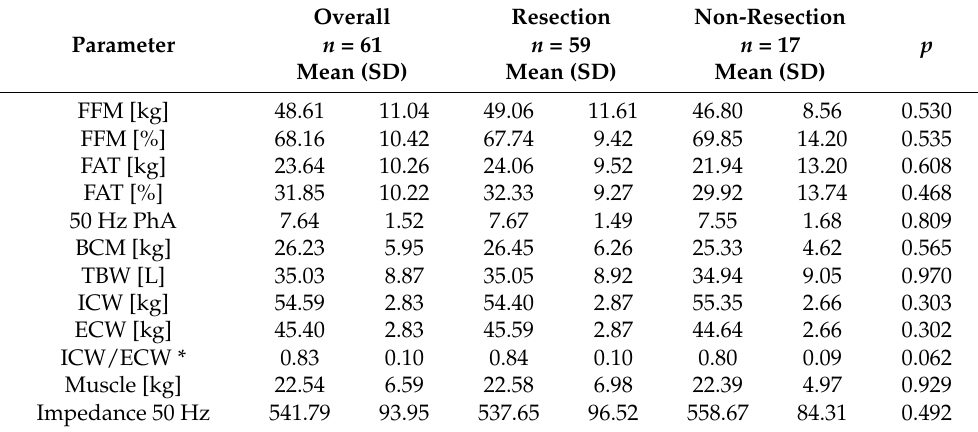
Table 2. Comparison of body composition parameters in resection and non-resection tumor